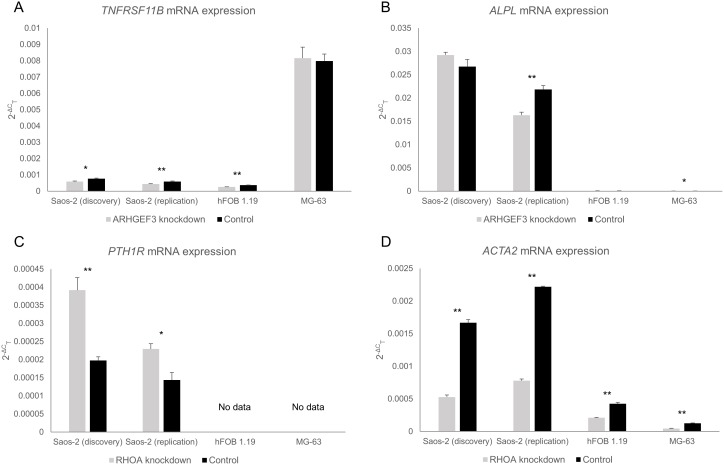
qRT-PCR validation of selected genes in response to ARHGEF3 and RHOA gene knockdown in osteoblast-like cells.(A) TNFRSF11B mRNA expression in osteoblast-like cells. (B) ALPL mRNA expression in osteoblast-like cells. (C) PTH1R mRNA expression in osteoblast-like cells. (D) ACTA2 mRNA expression in osteoblast-like cells. Data displayed as mean 2−ΔC
T ± SEM from three biological replicates. *P<0.05, **P<0.01.